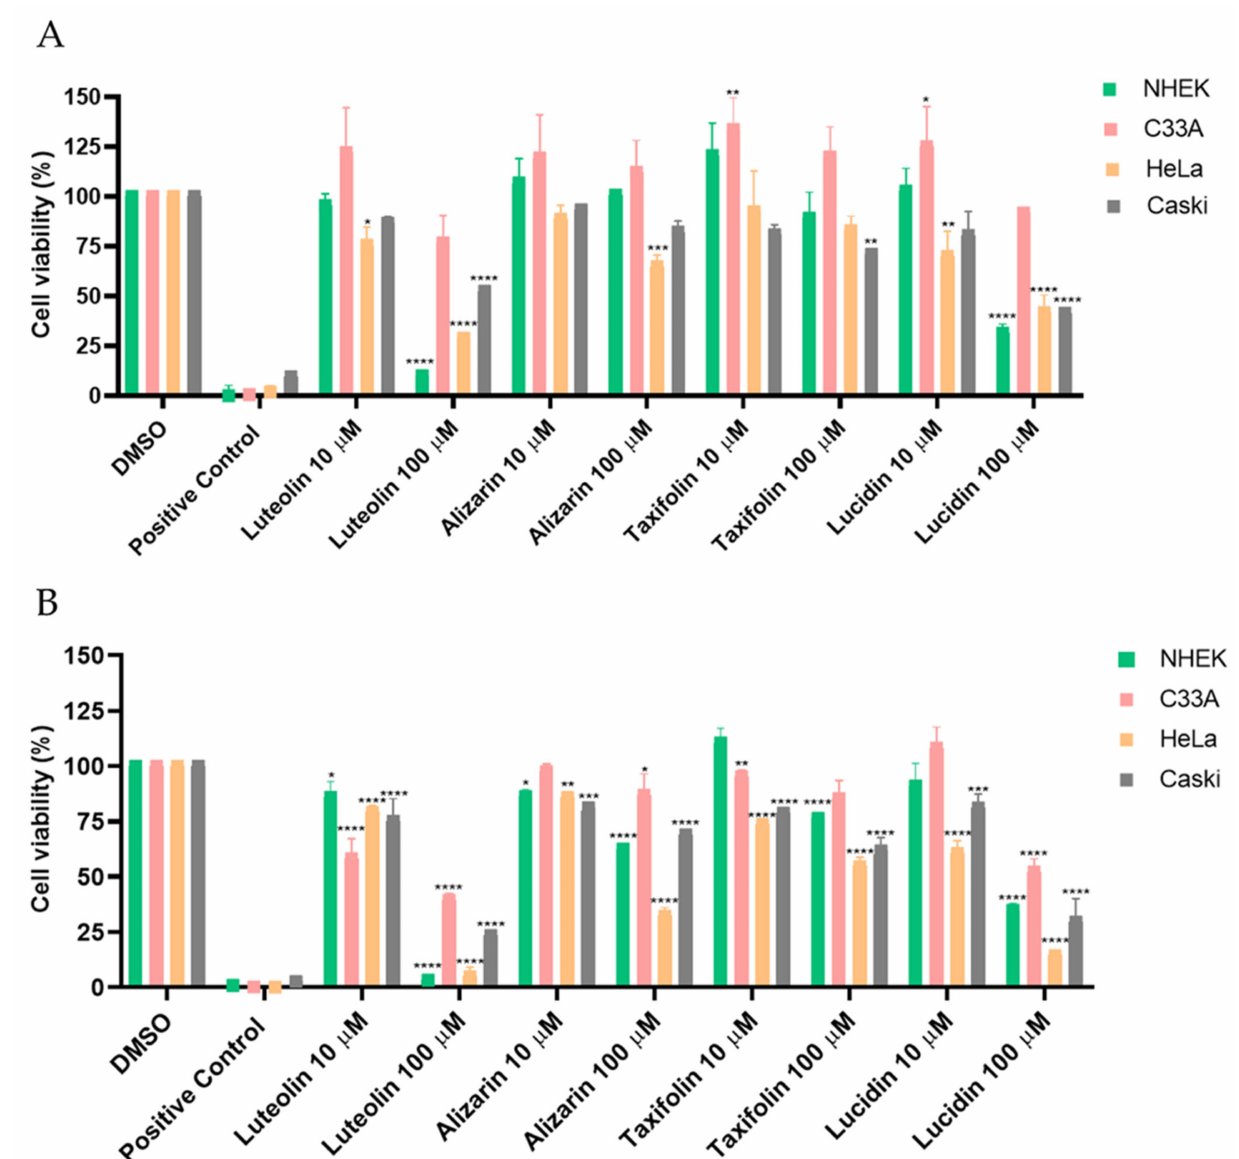
Figure 3. Cellular viability of different cell lines at 24 and 48 h incubation with phenolic compounds. All products were tested at 10 µ M and 100 µ M in HPV-positive (Caski and HeLa), negative (C33A) and non-carcinogenic (NHEK) cell lines by the MTT assay after 24 h ( A ) or 48 h ( B ) of treatment. Positive control corresponds to ethanol-treated cells. Percent viability was determined for each sample relative to the DMSO treated control samples. Data are presented as mean ± SD for three independent experiments ( n = 3) with four technical replicates and analyzed by one-way ANOVA with the Bonferroni test. Significance was determined as p -values * < 0.05, ** < 0.01, *** < 0.001, **** <